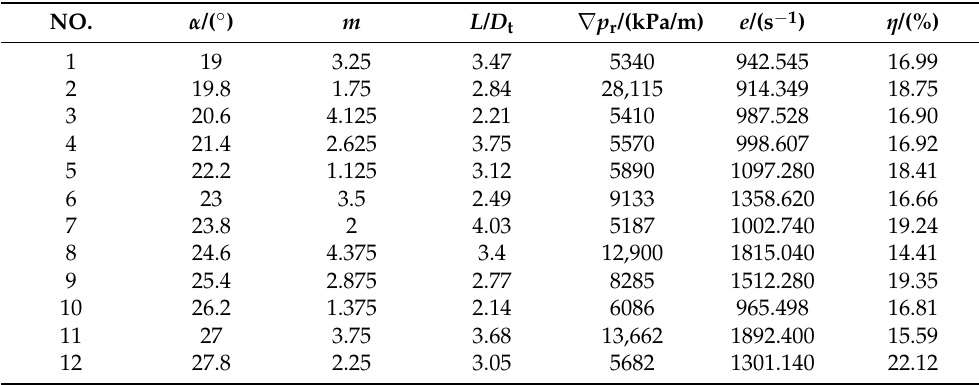
Table 2. Sample space of multi-objective